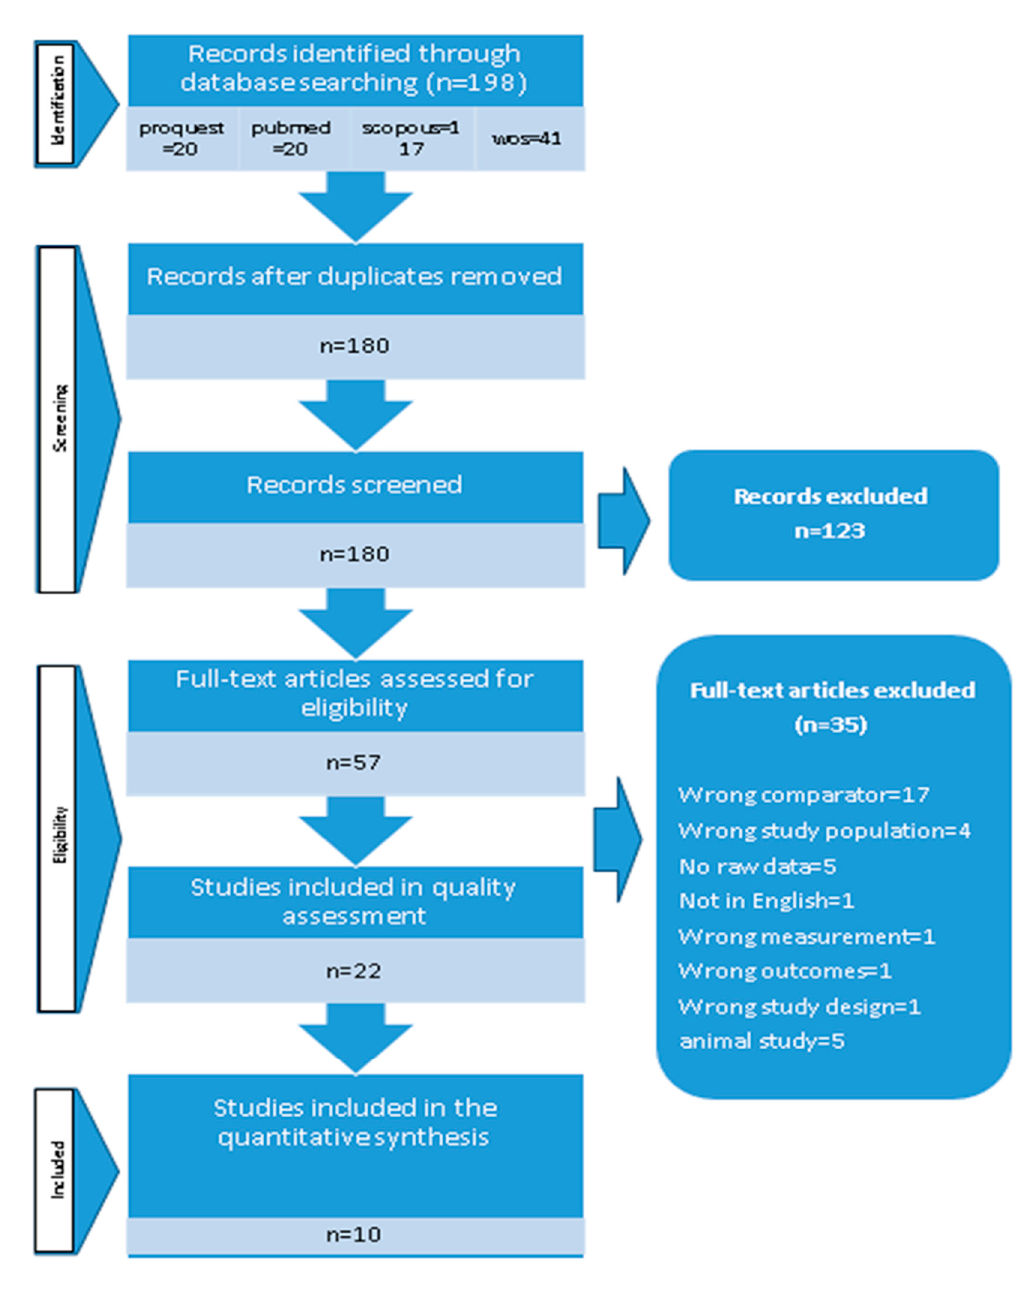
Figure 1. Search